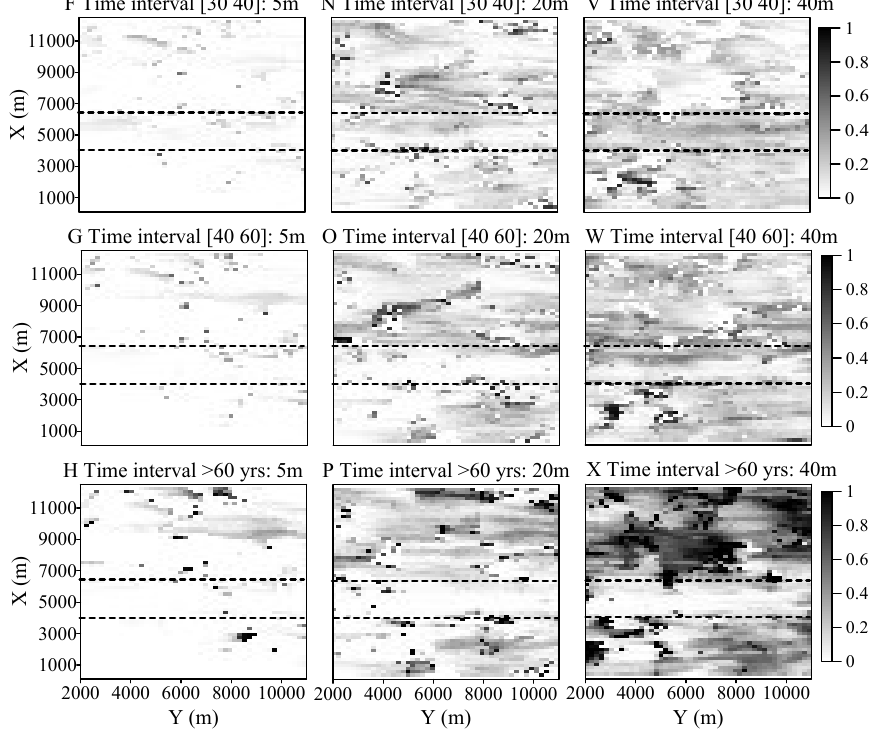
Figure 3. Sensitivity maps for saturated zone 5 m, 20 m, and 40 m below the water table. The areas between the two dashed lines shown in each figure represent the approximated surface areas of the IVF. The left, middle and right columns represent the results for aquifers 5, 20, and 40 m below the water table, respectively. In ( A ) the hydrofacies 1, 2, 3, 4, and 5 represent gravel, sand, muddy-sand, mud and paleosol, respectively; ( B ) shows the mean groundwater age, with a unit year; The cumulative BTTPD within the target time interval [0 10] yrs ( C ); [10 20] yrs ( D ); [20 30] yrs ( E ); [30 40] yrs ( F ); [40